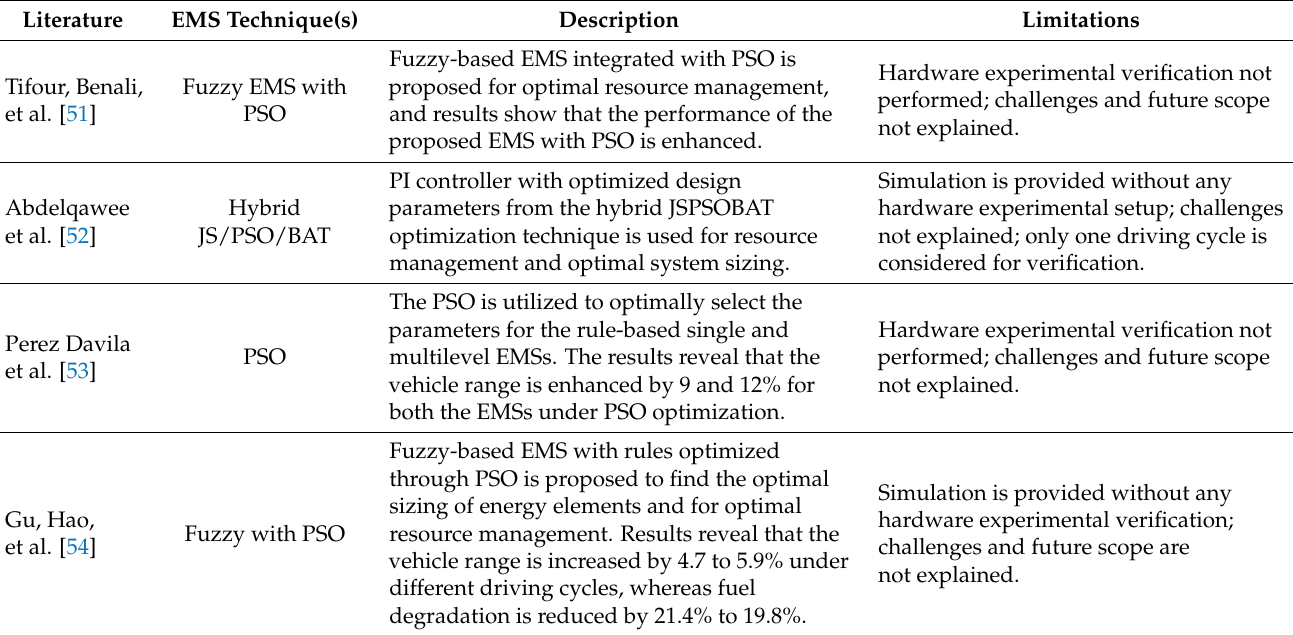
Table 4. Summary of the latest literature related to PSO-based